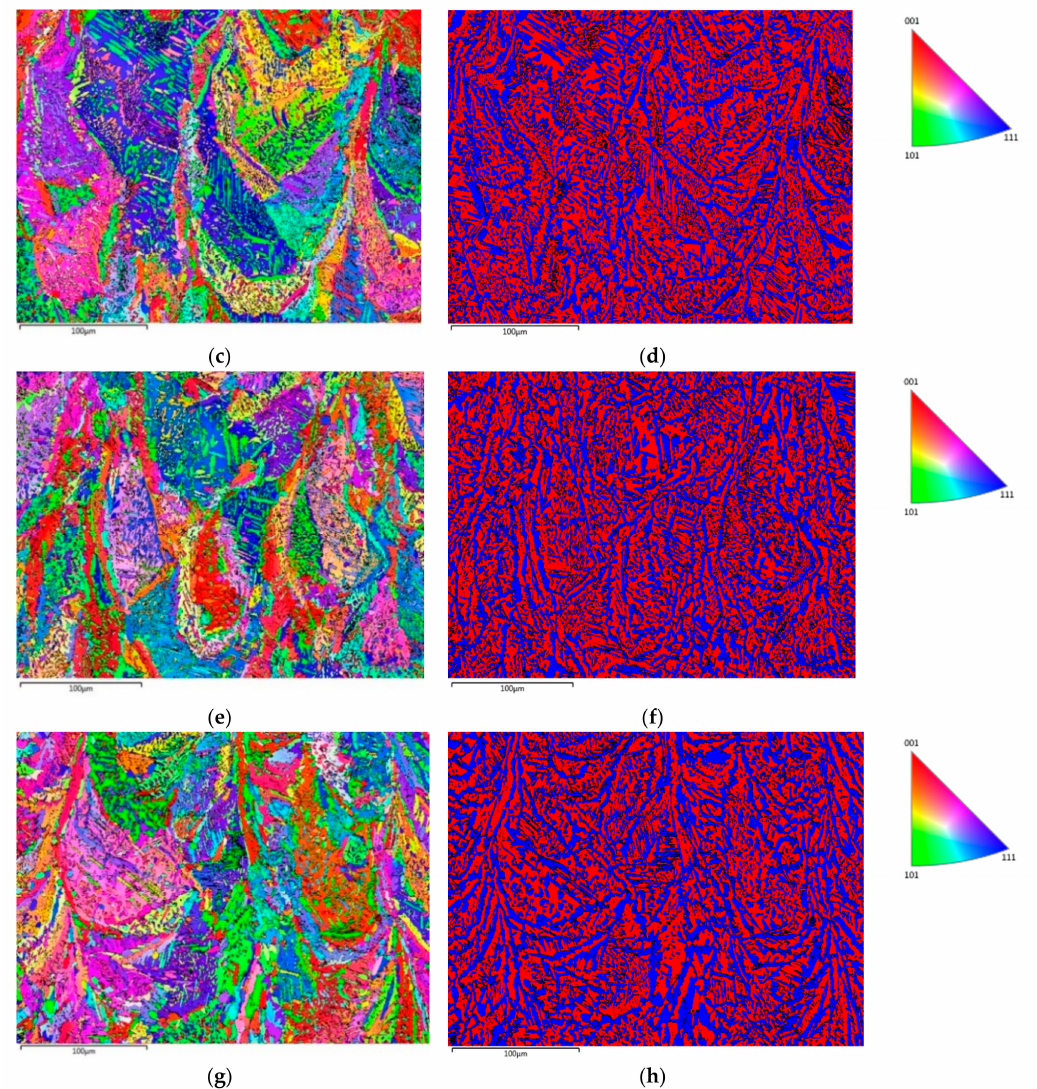
Figure 4. EBSD inverse pole figures ( a , c , e , g ) and phase maps ( b , d , f , h ) of the as-built specimen with 66 ◦ scanning rotation ( a , b ), specimen heat treated at 1000 ◦ C / 5 min ( c , d ), specimen heat treated at 1050 ◦ C / 5 min ( e , f ), and specimen heat treated at 1000 ◦ C / 60 min ( g , h ). Ferrite phase is colored with red and austenite phase with blue in the phase